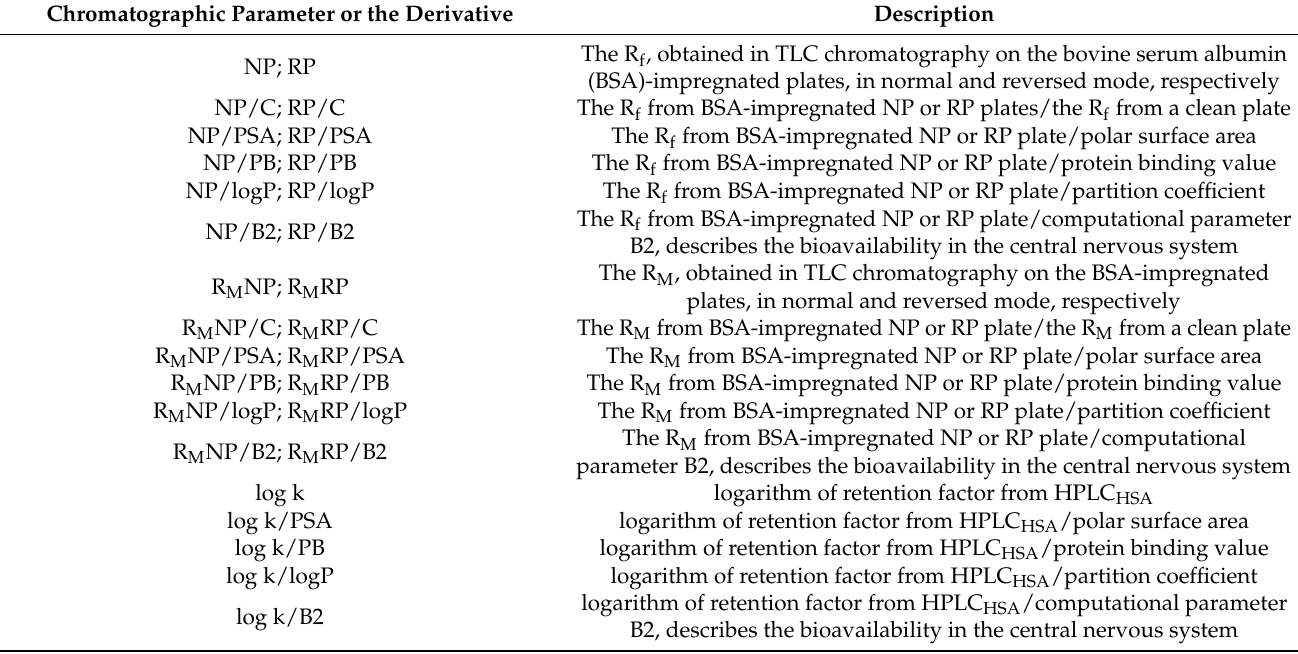
Table 1. Chromatographic parameters from normal phase/reverse phase thin-layer liquid chromatography (NP/RP TLC) and HPLC HSA experiments and their derivatives used in the analysis of analytical models as independent variables. Chromatographic Parameter or the Derivative